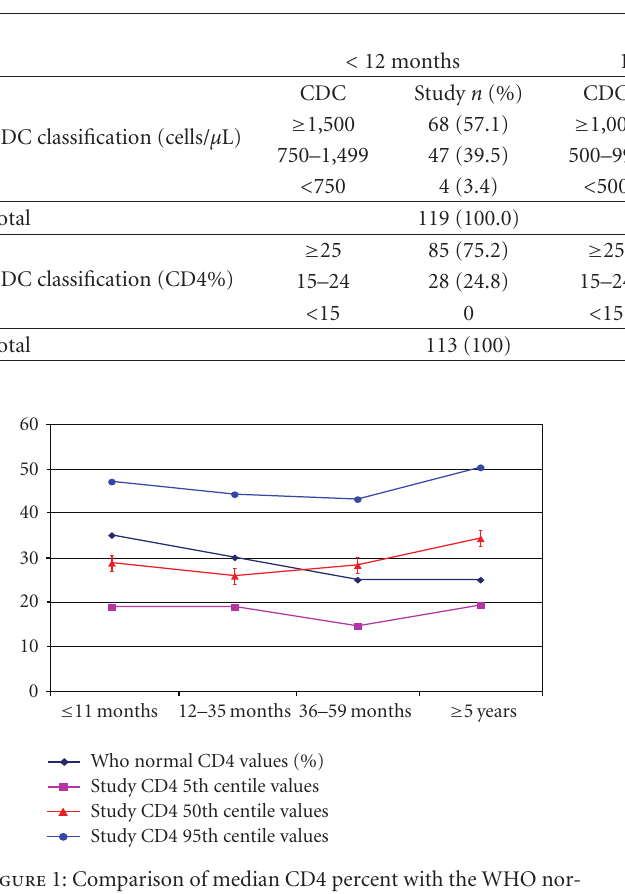
Figure 2: Comparison of the median CD4+ count by age with nor- mal CDC